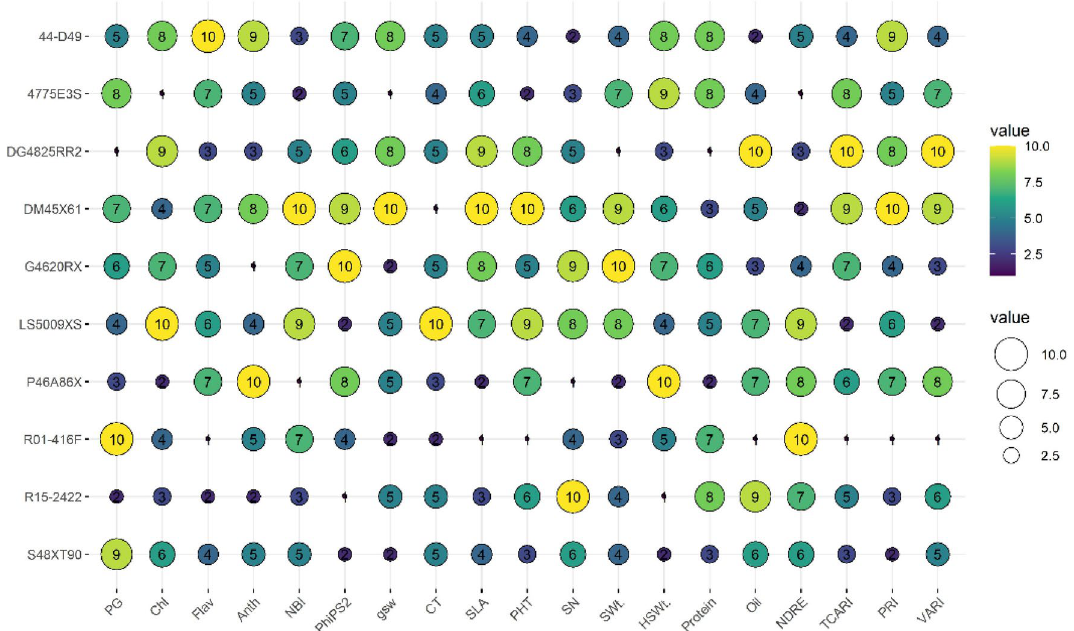
Figure 7. Bubble plot showing the variability in drought stress tolerance ranking of ten soybean cultivars. The high (10) and low (1) rank represents drought tolerant and sensitive cultivar or trait, respectively. Traits acronyms are given in the Table